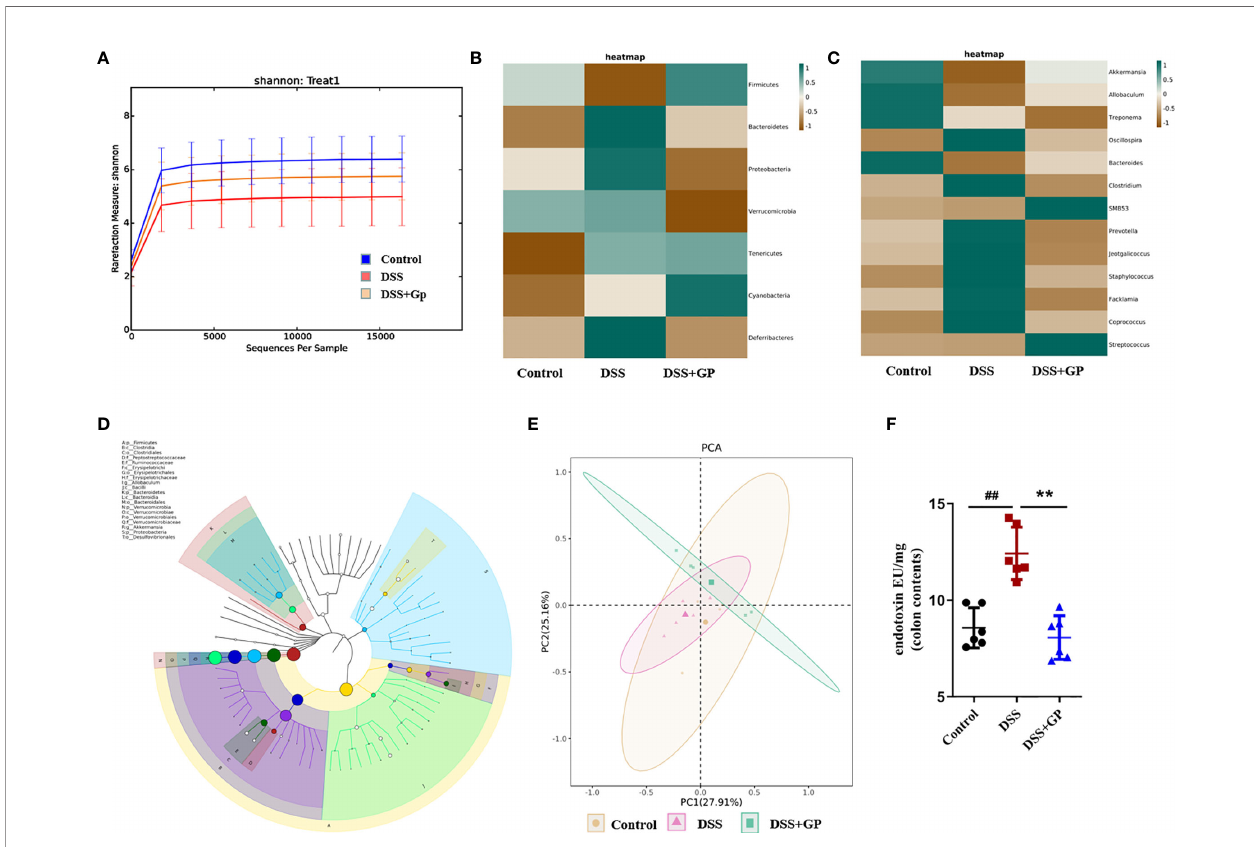
FIGURE 3 | Effects of GP on gut microbiota. (A) Rarefaction curves of OTU quantity. (B) Heatmap at the level of phylumgenus. (C) Heatmap at the level of genus. (D) A phylogenetictree of OTUs by GraPhlAn visualization. (E) PCA analysis. (F) LPS in colon contents. Bars in graphs represent mean ± SD, ## P < 0.01 VS Control group; **P < 0.01 VS DSS